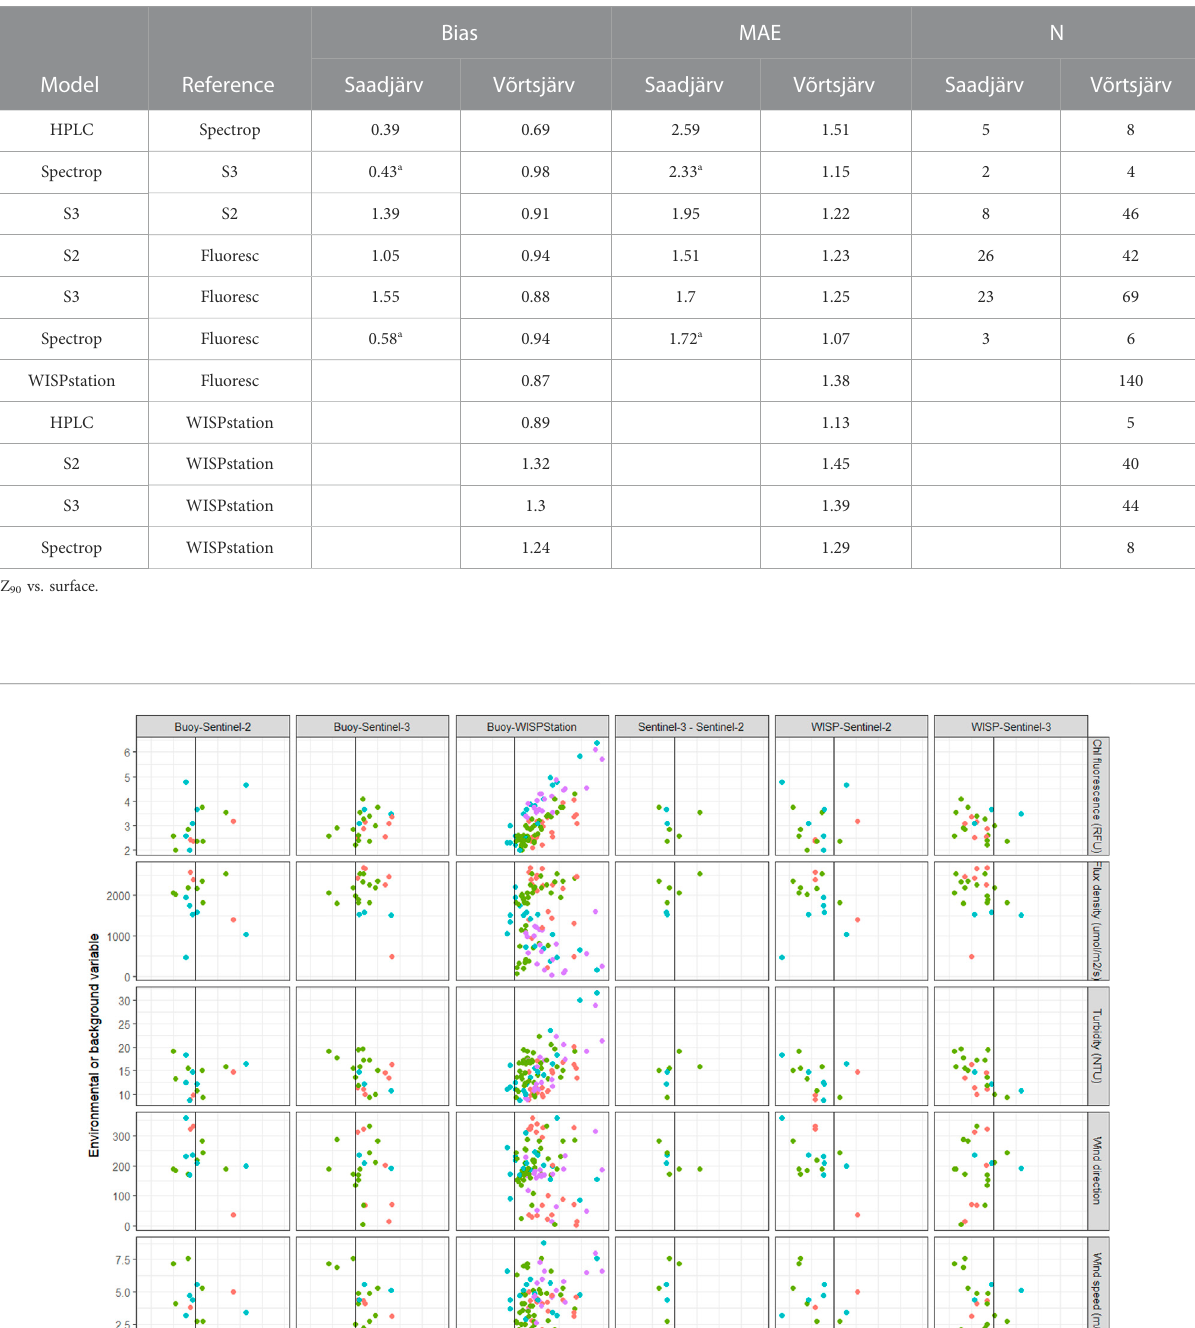
TABLE 4 Evaluated bias and mean absolute error (MAE) between studied methods according to Eqs 4, 5.